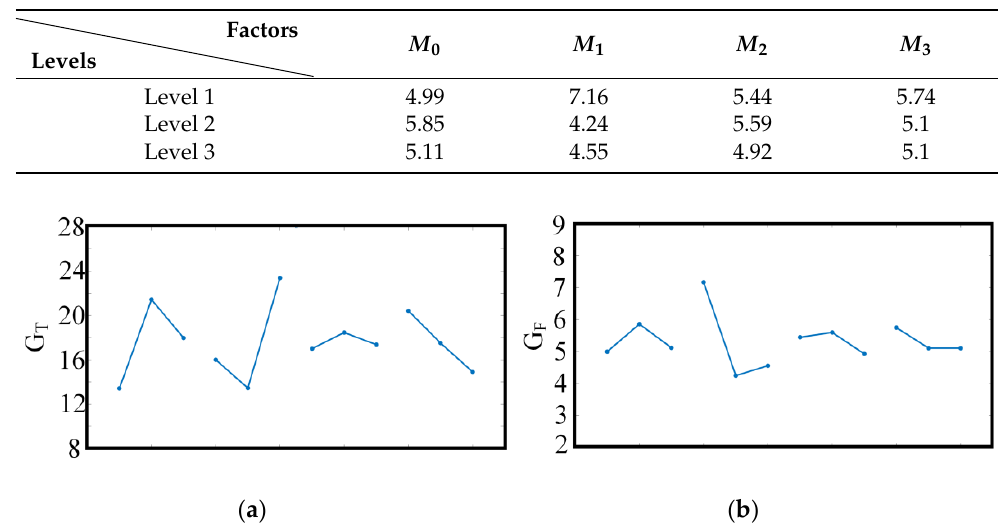
Table 6. Average Value of Different Factors on G F .